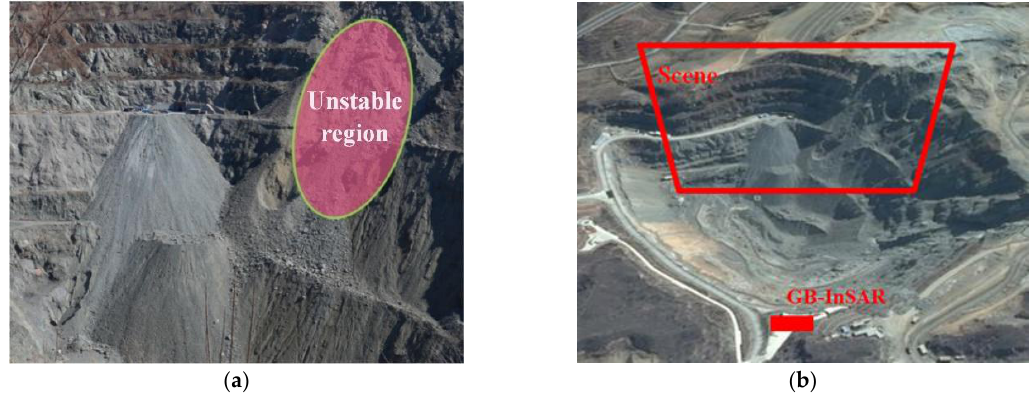
Figure 5. Deformation monitoring for case study 1: ( a ) the optical photo and ( b ) the aerial view on Google Earth.